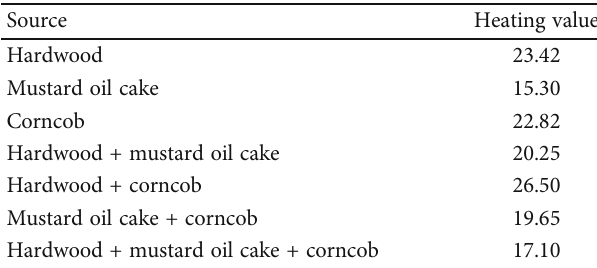
Figure 7: Product yield from co-pyrolysis with ternary blends. Table 5: Heating value of the